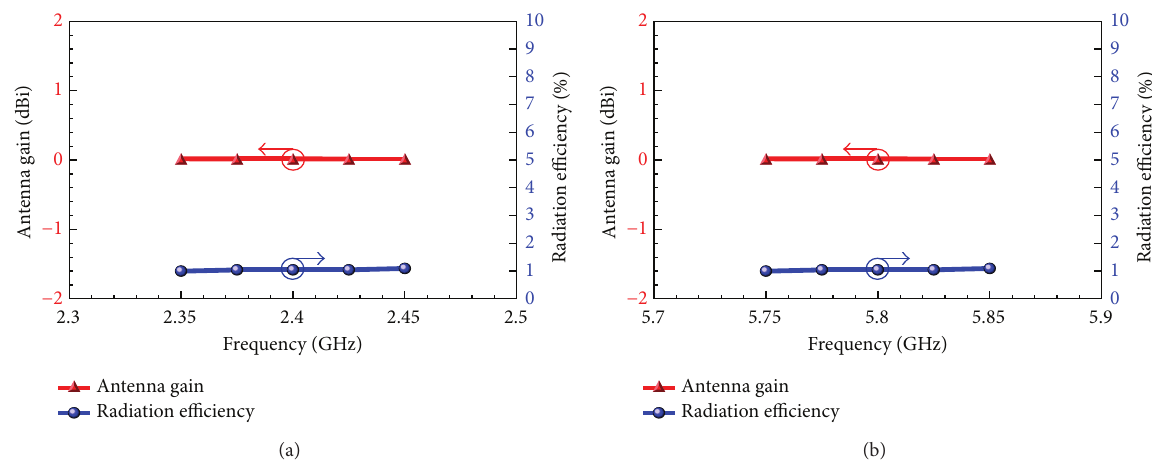
Figure 9: Measured radiation efficiency of the proposed antenna: (a) 2.3–2.5 GHz; (b) 5.7–5.9